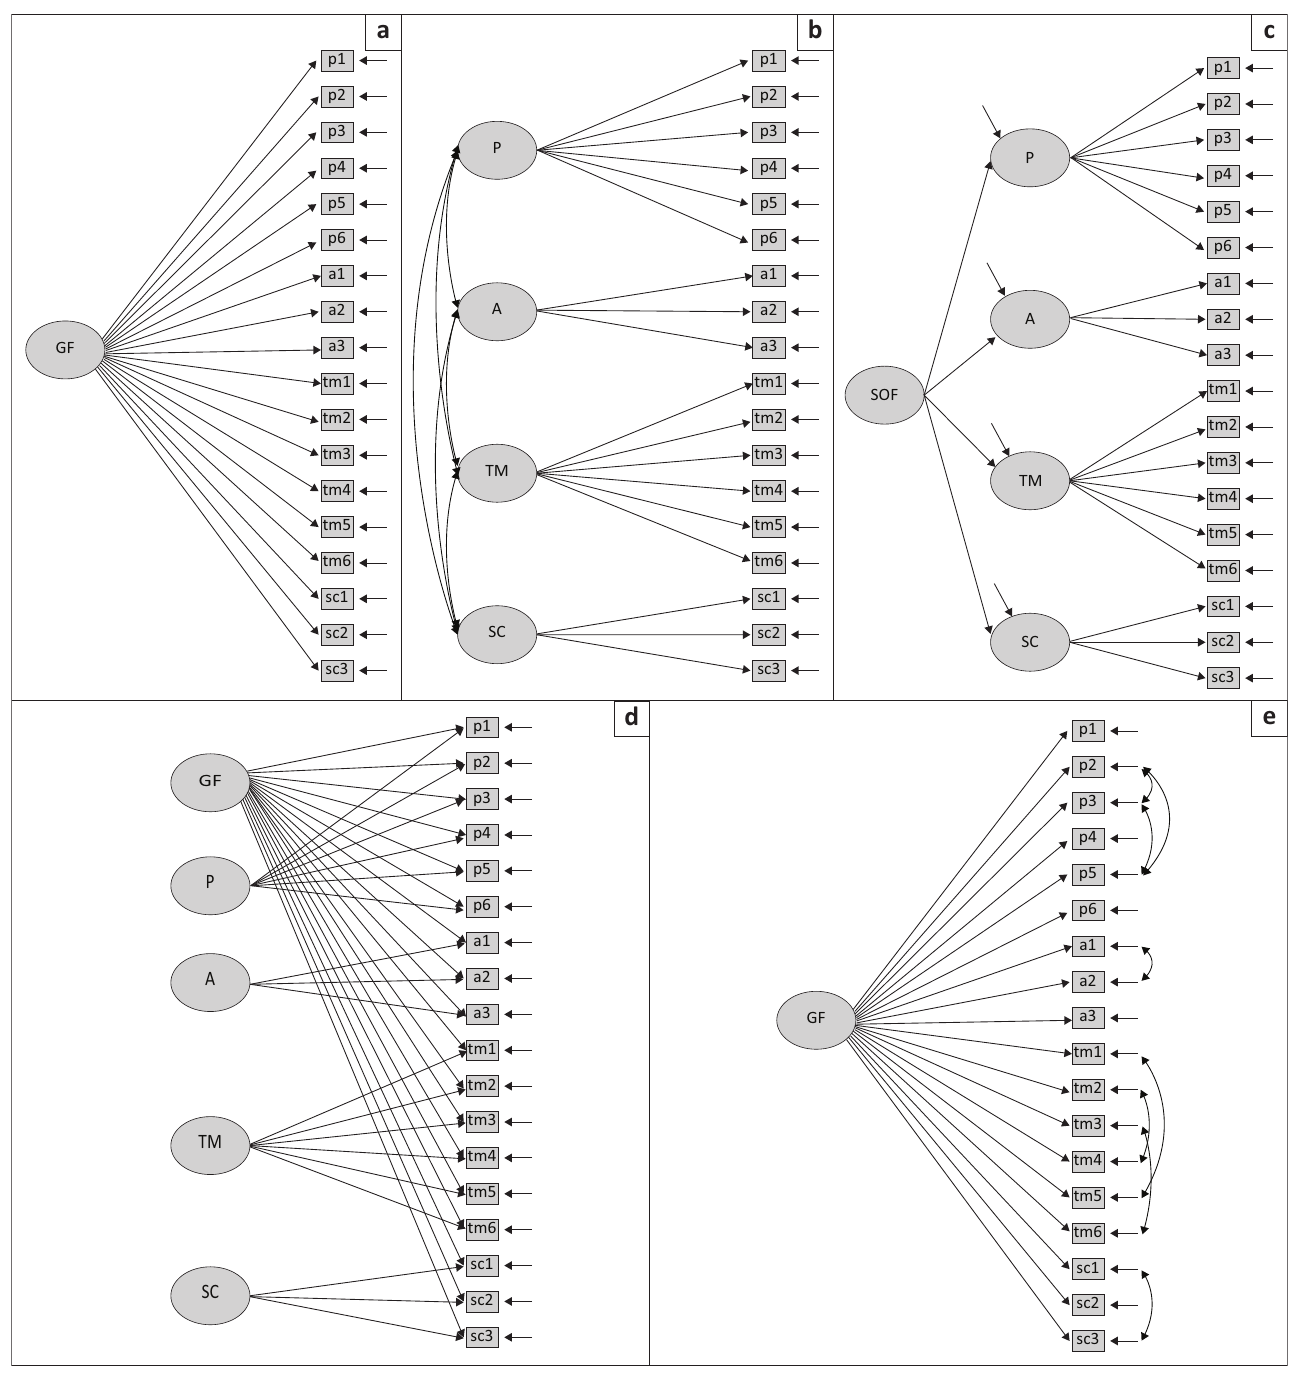
FIGURE 1: Models tested: (a) one-factor model, (b) four-factor model, (c) second-order factor model, (d) bifactor model and (e) one-factor model with method